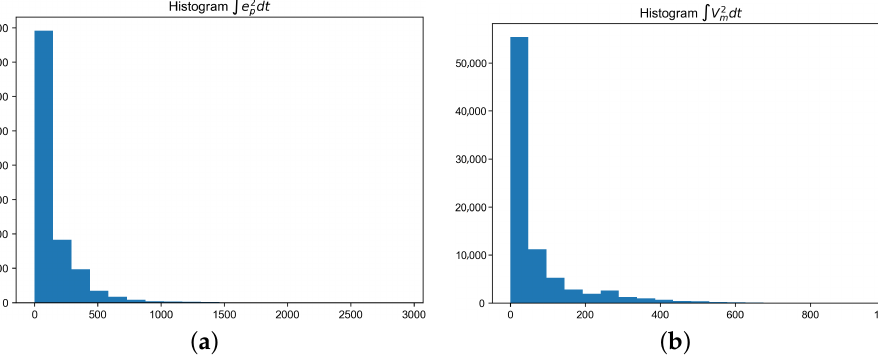
Figure 11. Algorithm 3—distributions of performance factors (histograms): ( a )